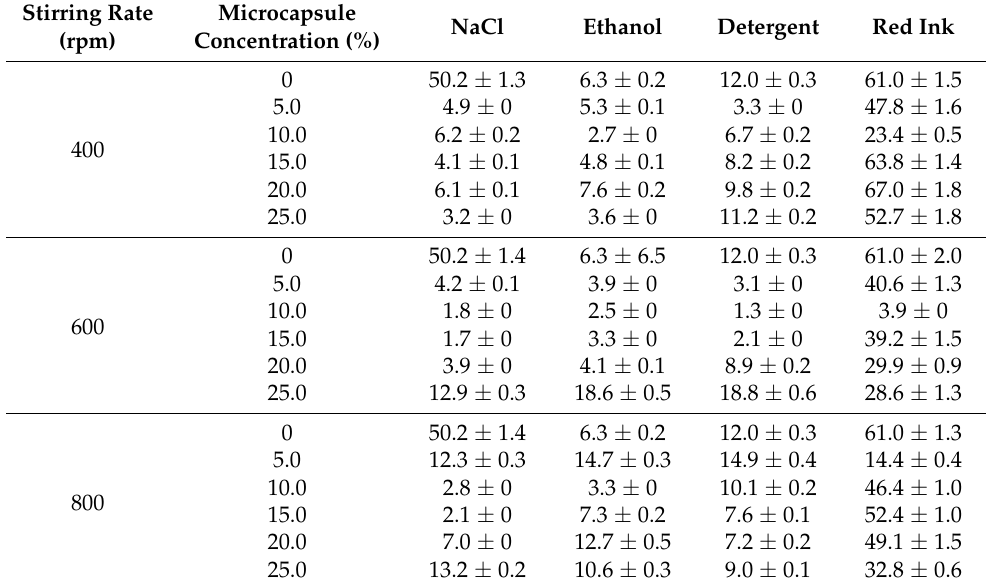
Table 6. Effect of the concentration of microcapsules with different stirring rates on the color difference of waterborne primer